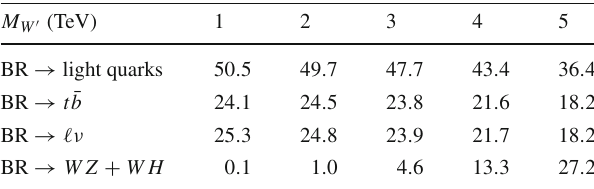
Table 2 W (cid:2) branching ratios in per cent for ξ W − W (cid:2) = 10 − 3 M W (cid:2) (TeV)